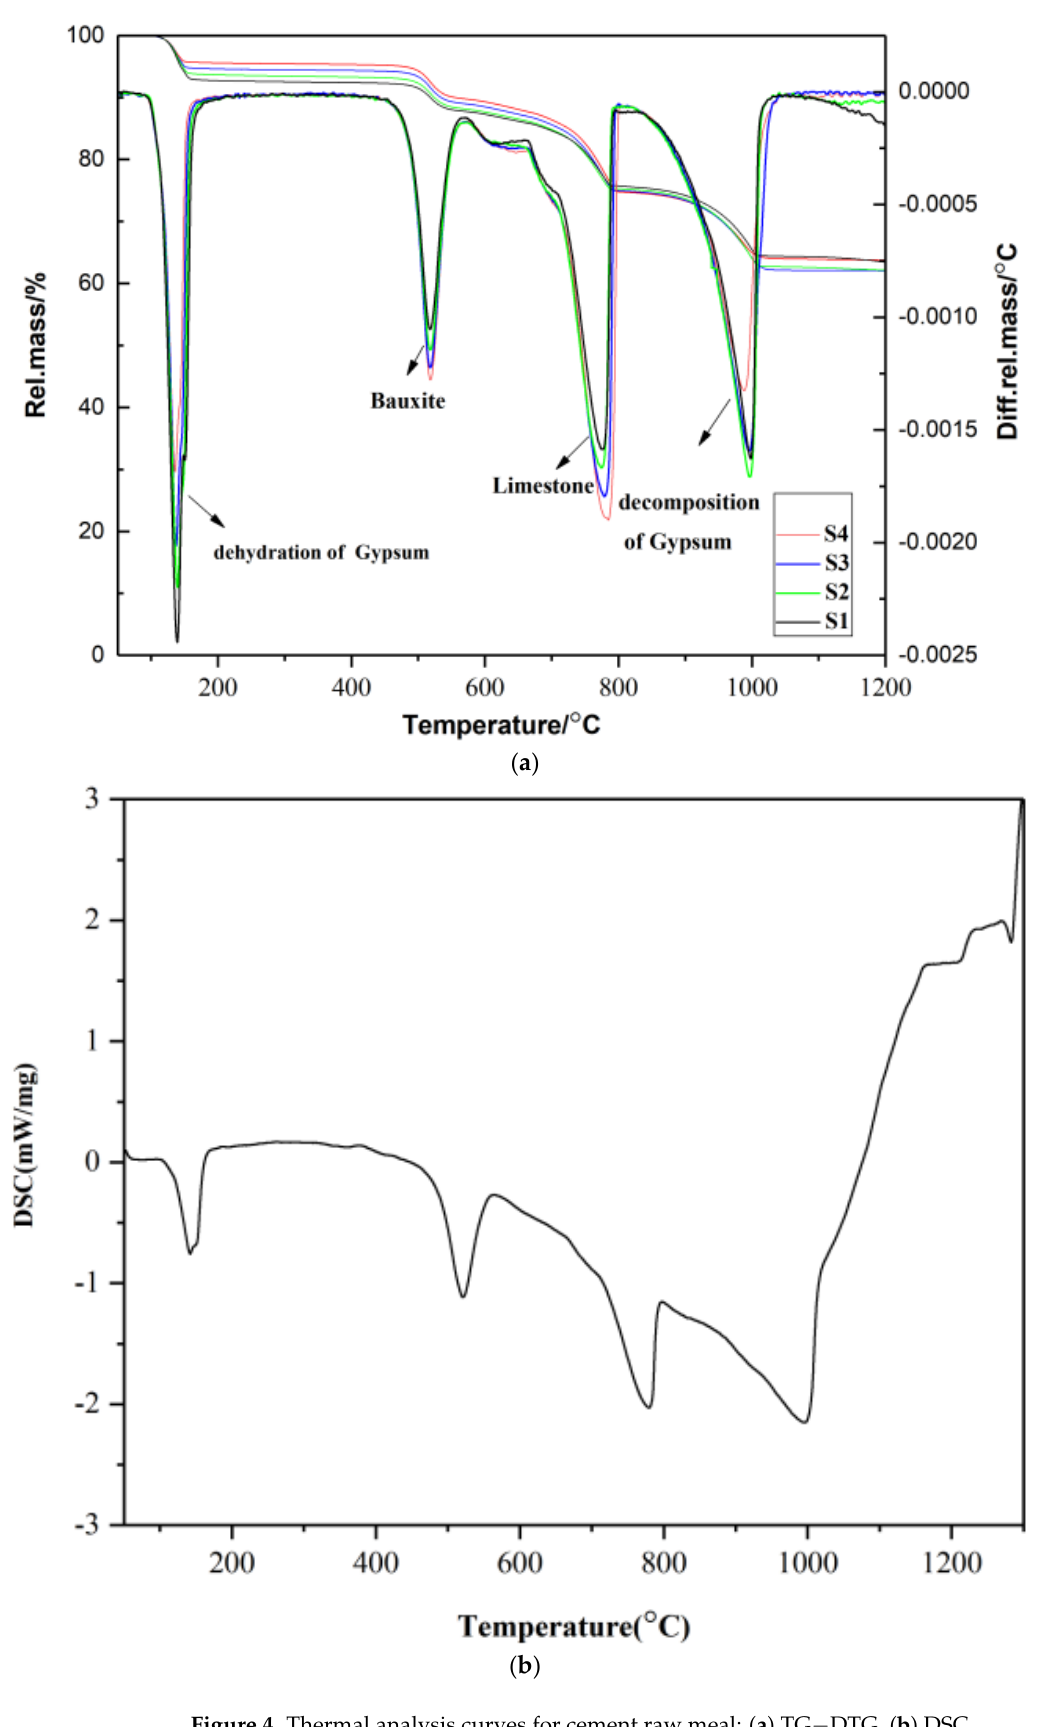
Figure 4. Thermal analysis curves for cement raw meal: ( a ) TG − DTG. ( b )